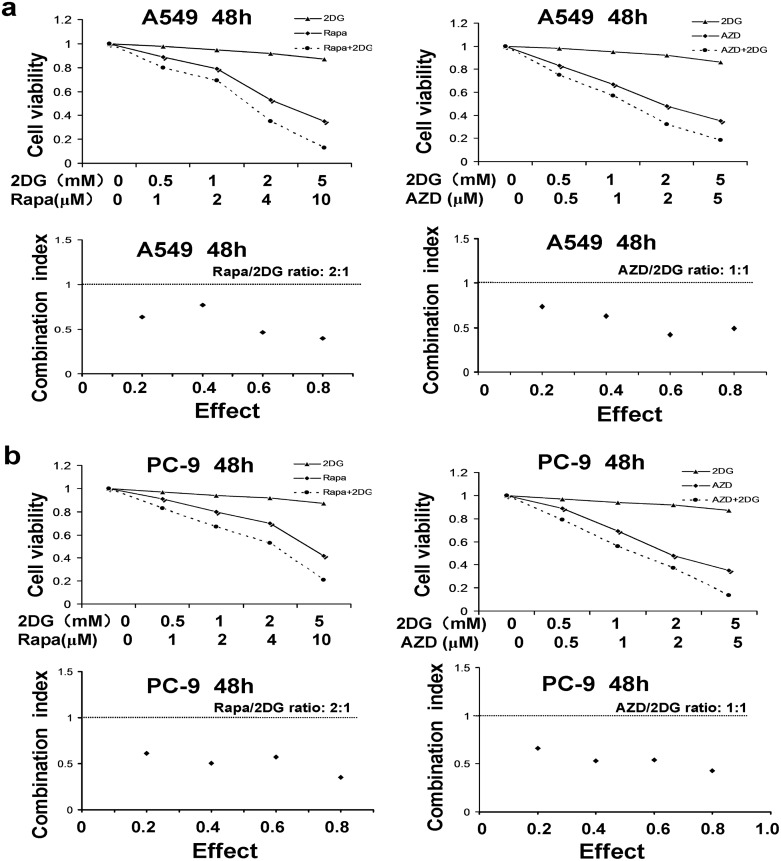
The combination index of mTOR inhibitors and glycolysis inhibitor on cell viability reduction in NSCLC cells.(a) and (b) The dose–response curve of each drug was determined and the combination index (CI) values for rapamycin/2-DG concentration ratios (2:1) and AZD2014/2-DG concentration ratios(1:1) were calculated according to Chou–Talalay’s method at 48 h time point. CI < 1, CI = 1, and CI > 1 indicate synergistic, additive and antagonistic effects, respectively. The effect ranges from 0 (no inhibition) to 1 (complete inhibition). The data are representative of three independent experiments.